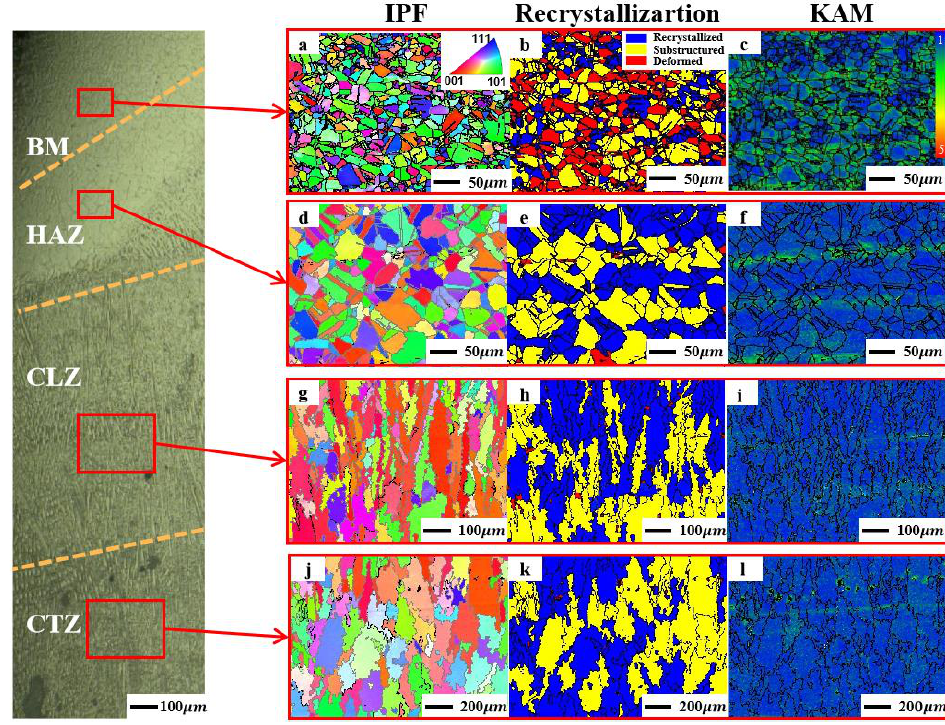
Figure 6. The IPF, recrystallization diagram, and kernel average misorientation (KAM) diagram of different areas of the sample after 760 mA electron beam scanning: ( a,b,c ) BM, ( d,e,f ) HAZ, ( g,h,i ) CLZ, ( j,k,l ) CTZ.